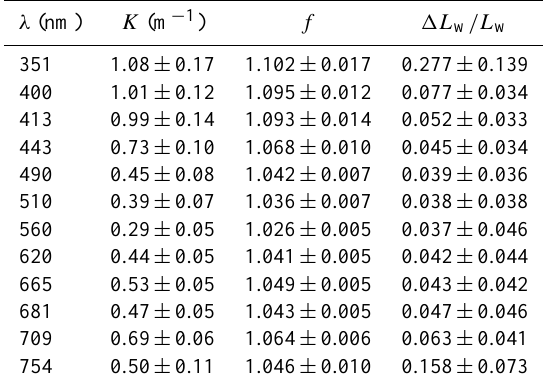
Table 2. Mean value ± standard deviation of the vertical attenuation coefficient K of sub-surface radiance from nadir, of the correction factor f for self-shading by the radiance sensor, and of the rela- tive uncertainty (cid:49)L w /L w of the water-leaving radiance at different wavelengths λ . The number of analysed data sets is